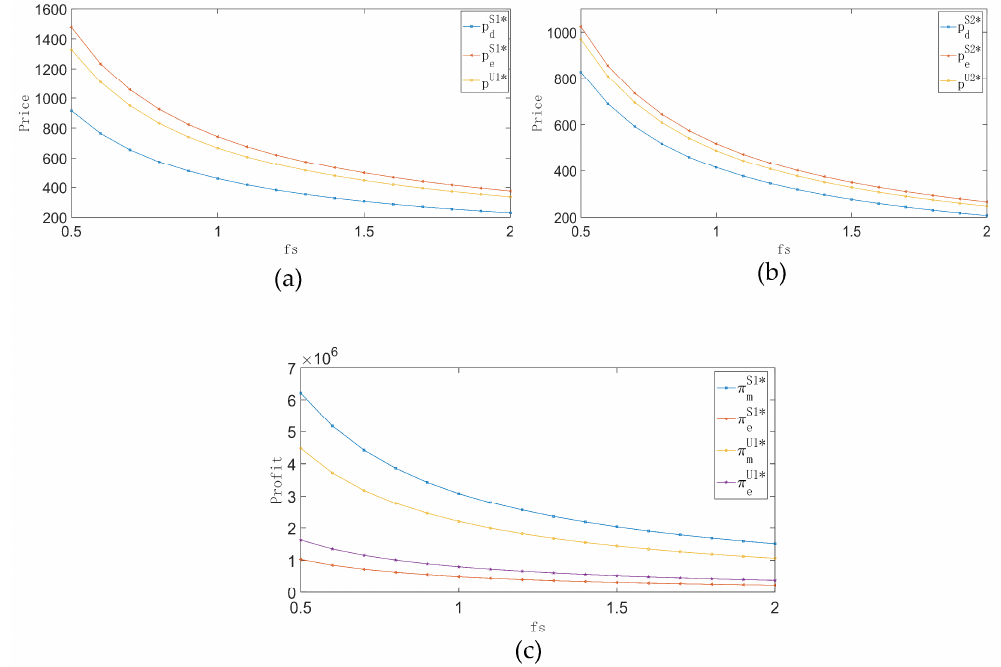
f f on equilibrium results. ( a ) The impact of b f on sales price under f b on profits of two parties under the